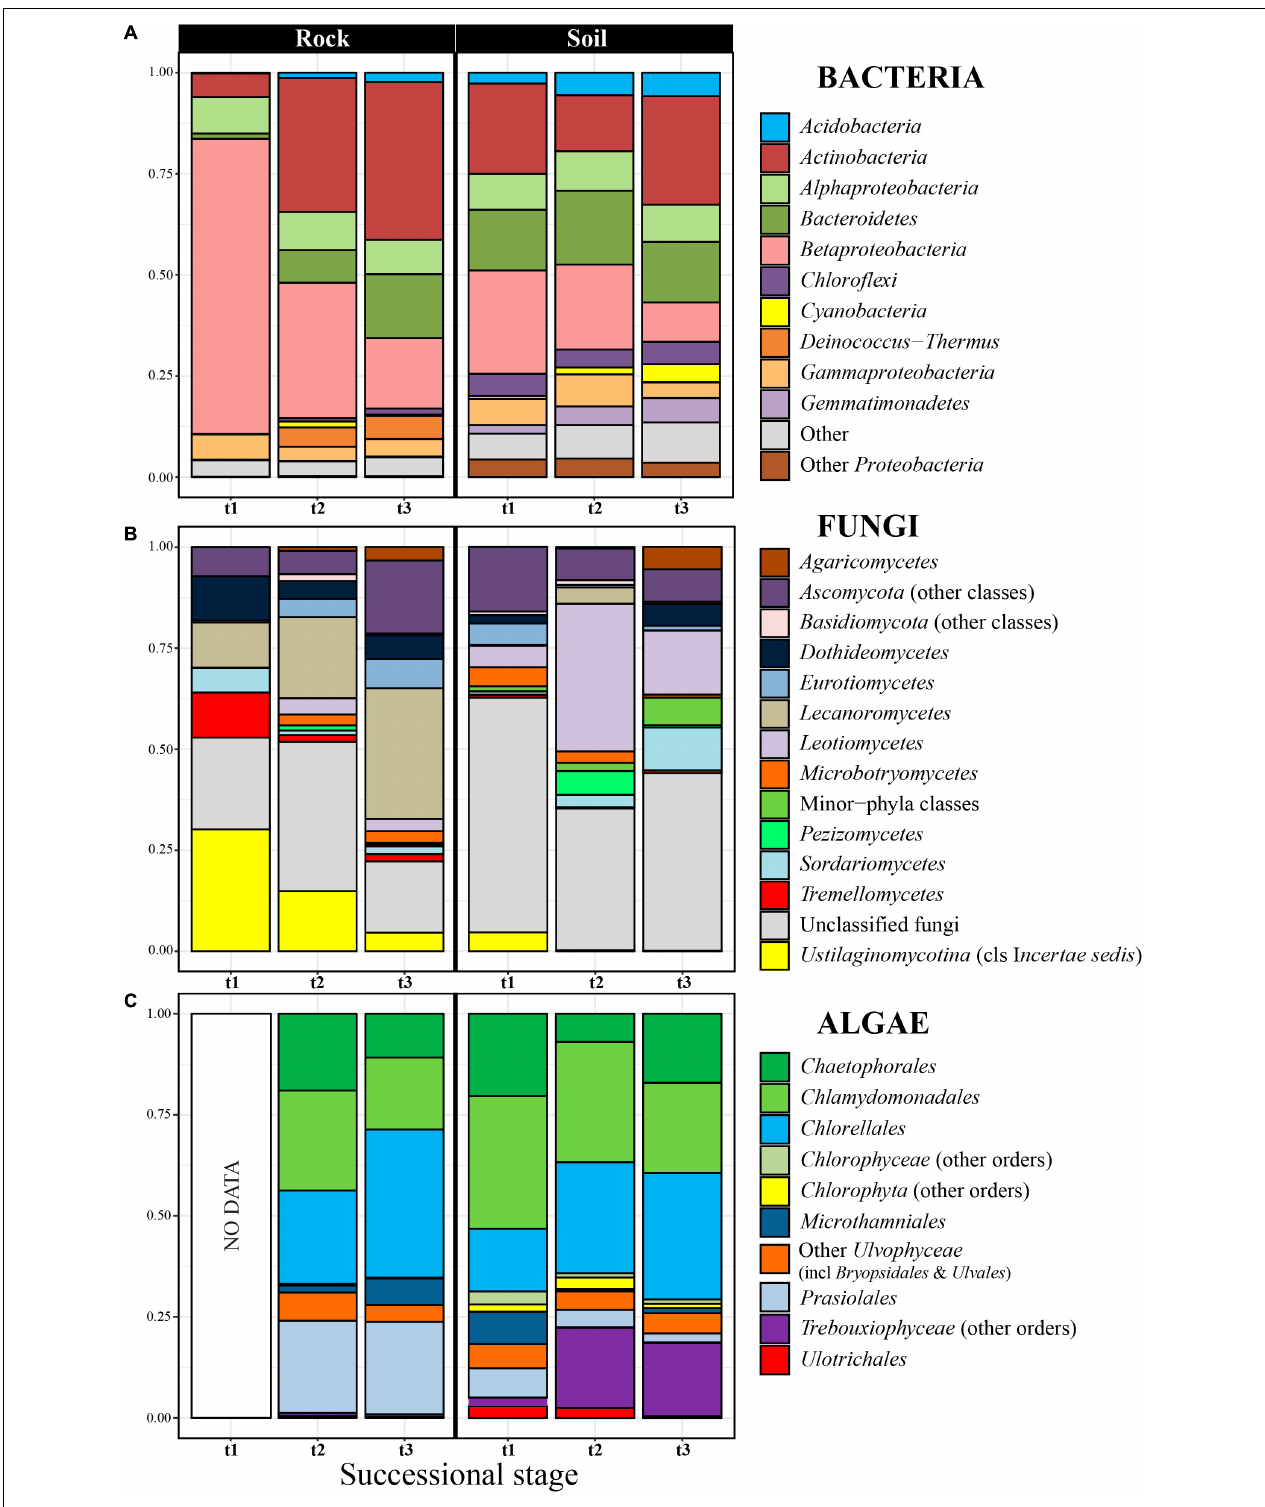
FIGURE 2 | Relative abundance of bacterial phyla (A) , fungal classes (B) , and algal orders (C) in rocks and soil at the three considered successional stages. Each taxon proportion was calculated as the arithmetic mean of several replicate samples (see Supplementary Figures S3 , S7 , S8 to check proportions per replicate). The bacterial phylum Proteobacteria was explicitly subdivided into its three most abundant classes in our dataset ( Alpha -, Beta - and Gammaproteobacteria ).